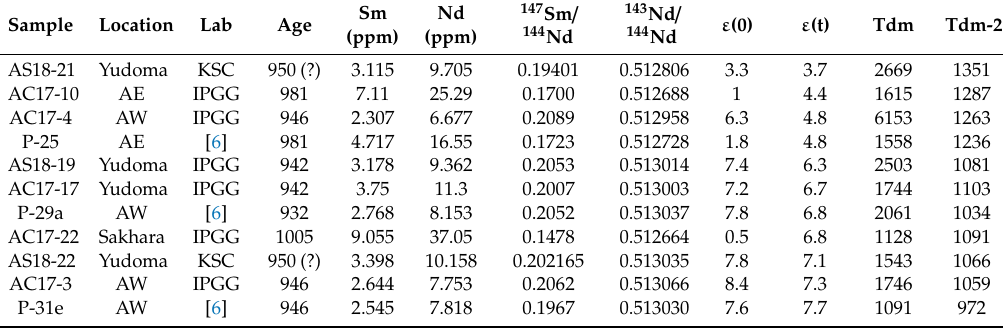
Table 1. Whole-rock Sm-Nd isotope results. This study: IPGG (Institute of Precambrian Geology and Geochronology) and KSC (Kola Science Center RAS); Khudoley et al. [6]. See coordinates of samples